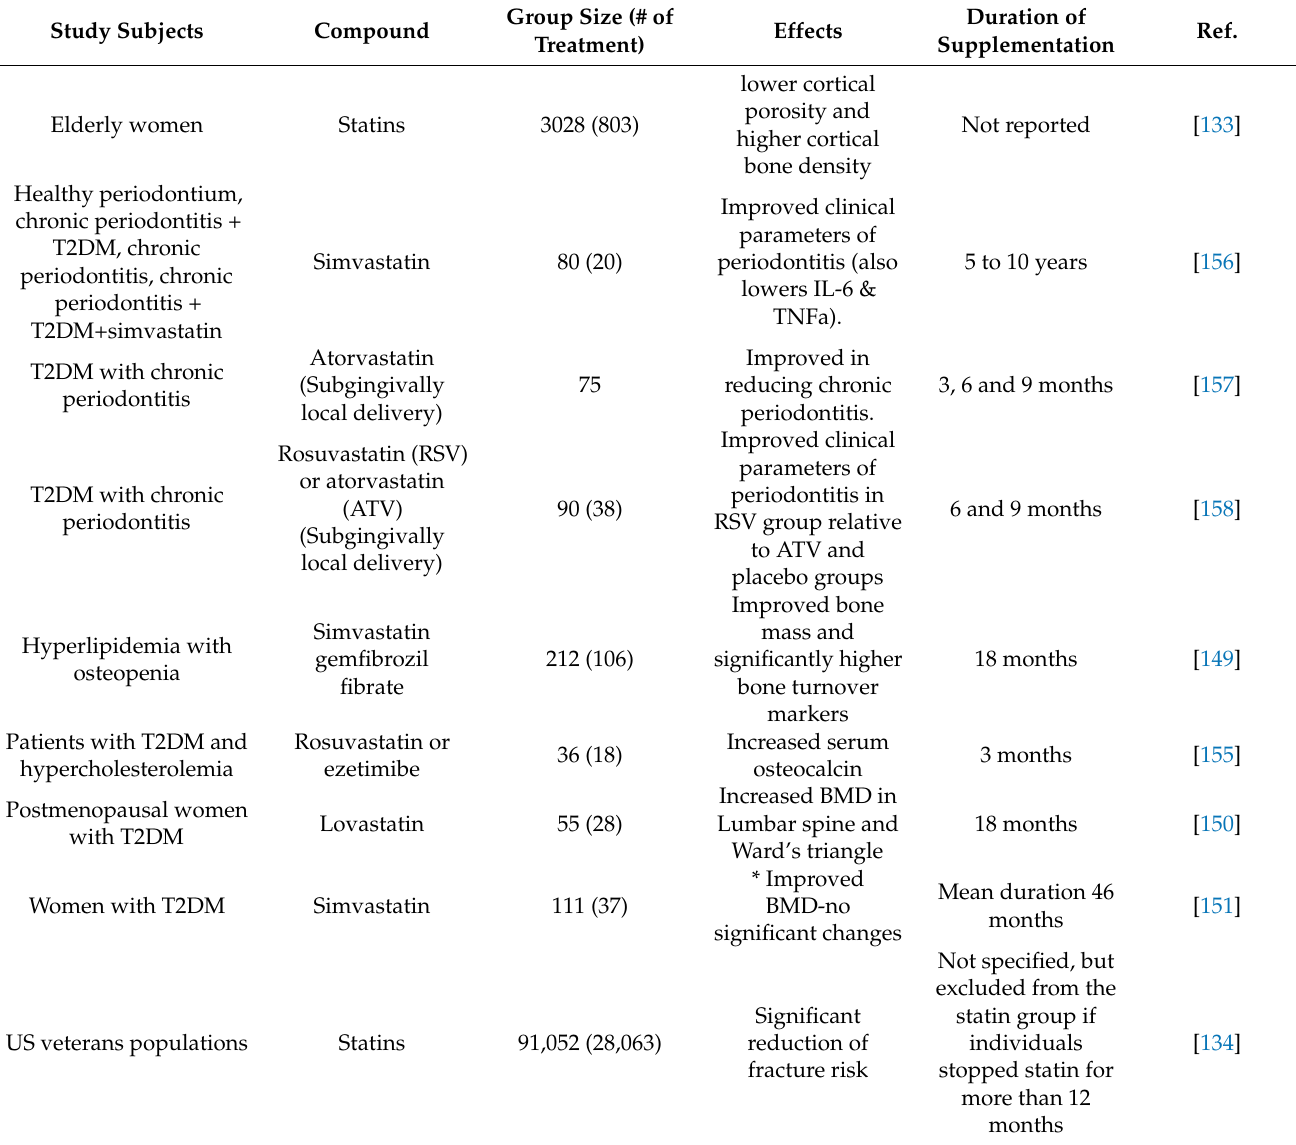
Table 1. Statins in clinical